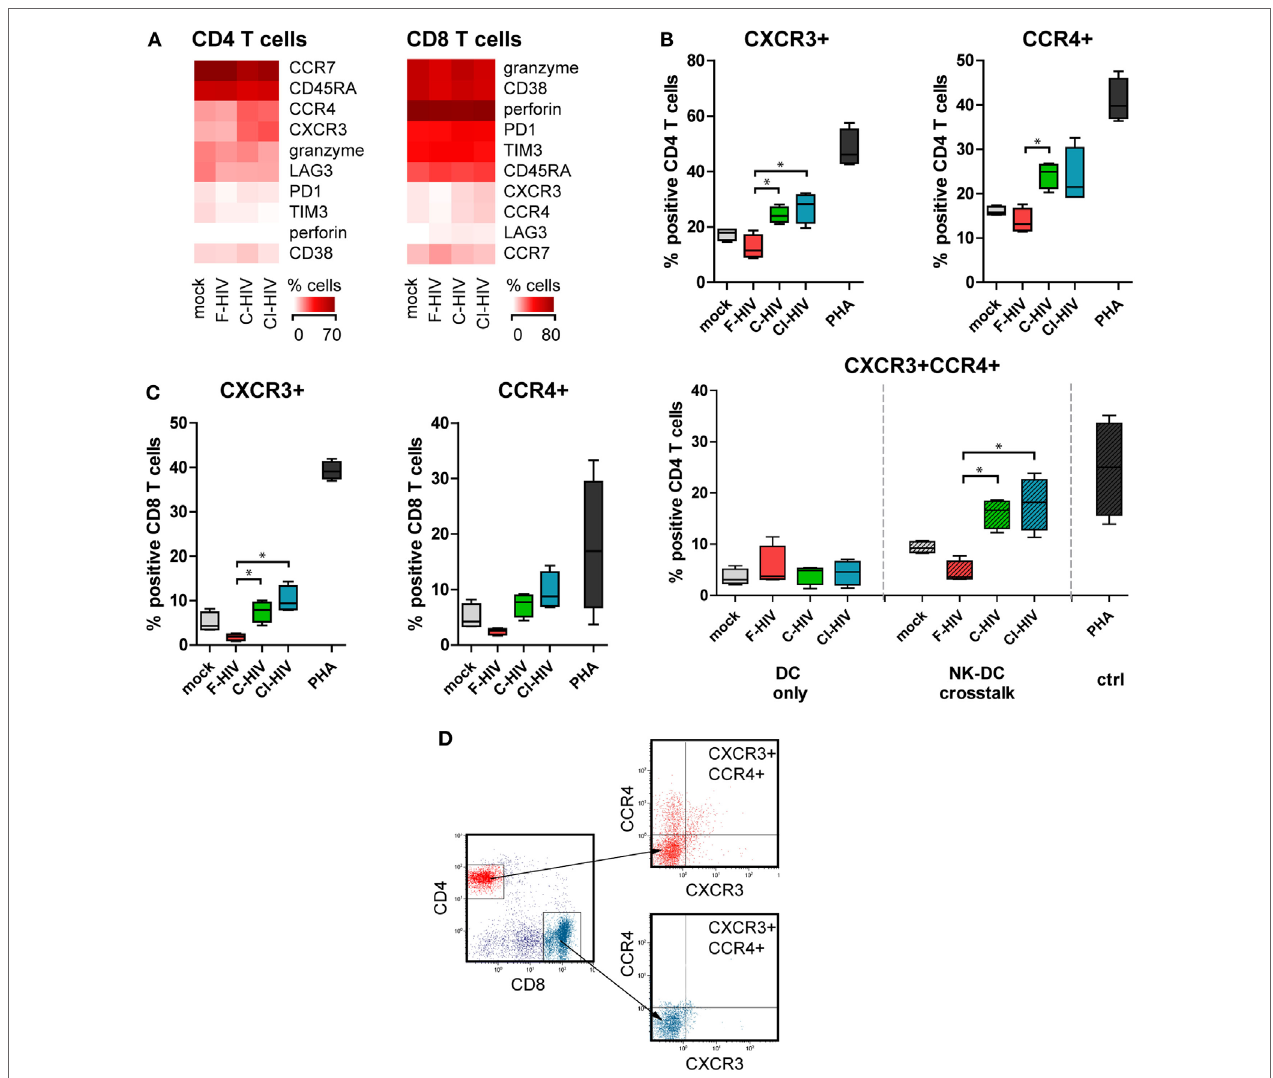
FigUre 7 | T cell phenotype activated by natural killer (NK)–dendritic cell (DC) stimulation assay. DCs and NK cells from the same donor were cocultured and exposed to 1 μ g/ml F-HIV, complement-opsonized HIV (C-HIV), complement- and antibody opsonized HIV (CI-HIV), PHA, or mock treated for 24 h. The experiment was replicated four times using cells derived from four different donors. Allogeneic T cells were then added to the cultures at a 1:10 DC:T cell ratio. (a) The T cell phenotype induced was assessed by flow cytometry. Heat maps of the percentage of CD4 and CD8 cells positive for phenotypic markers were created. (B) The number of CD4 T cells positive for CXCR3 or CCR4 were evaluated in culture with DCs conditioned with NK cells, and the number of CD4 T cells positive for both CXCR3 and CCR4 were evaluated in culture with DCs conditioned with NK cells or DCs alone. (c) The number of CD8 T cells positive for CXCR3 and CCR4 was evaluated in culture with DCs conditioned with NK cells. (D) Gating strategy for flow cytometry analysis of a representative sample can be seen. Boxplots show mean with Tukey error bars. One-way ANOVA followed by a Bonferroni posttest was used to test for statistical significance (* p < 0.05, N =